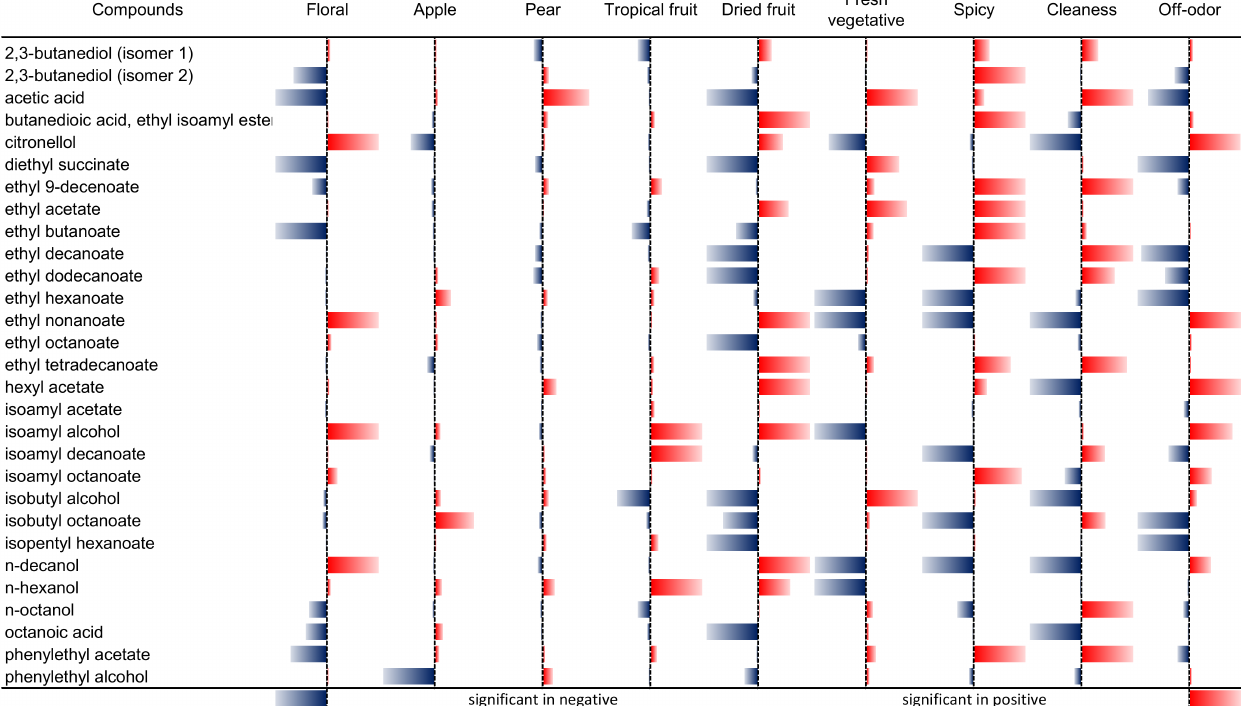
Figure 3. Summary of the calculated p -values and standardized coefficients of the volatile compounds in the regression models. The absolute length of the bars represents the significance expressed as “1/ p -value”; consequently, the longer the bar is, the more significant is the effect of that compound. The colour and the direction of the bar indicate instead the sign of the standardized coefficient in the respective regression equation: Red = positive sign/correlation, Blue = negative